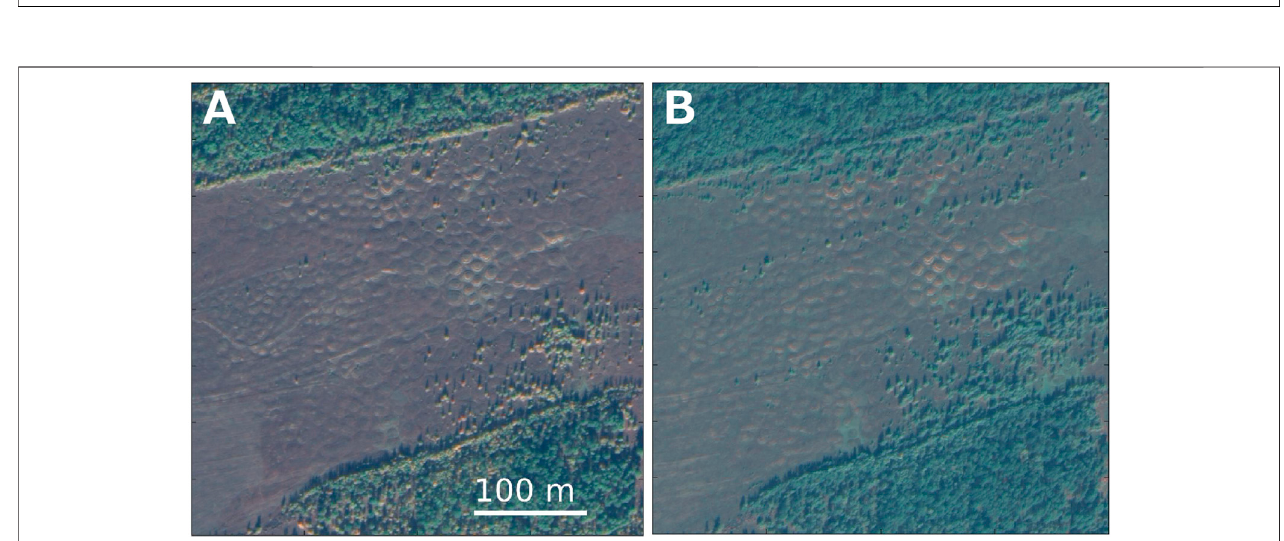
FIGURE8| Comparison ofthepan-sharpenedimages inarablelandareaAin Figure2B derivedfromthe (A) Worldview-2image onSeptember 11, 2011and (B) Worldview-3 image on August 27, 2019.